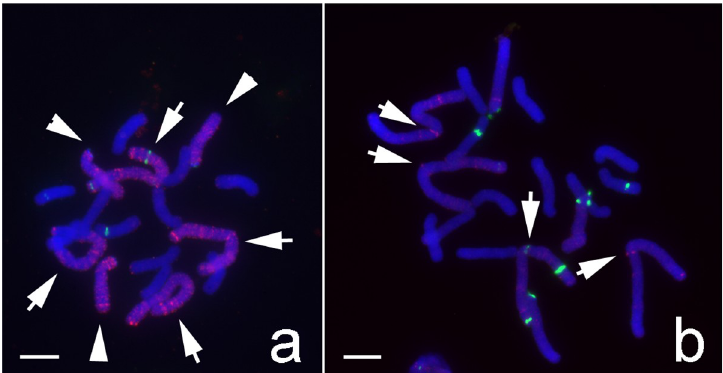
Fig 8. FISH assay showing the abundance and specific distribution of LaCENH3-associated ChIP DNAs on mitotic metaphase chromosomes of hybrid L . aurea × L . radiata (2n = 18, 4M+3T+11A). (Scale bar = 10 μ m). (a) An example of FISH signal pattern for most of the ChIP clones tested shows strong signals (red) dispersed on M-type (arrow) and T-type (arrowhead) chromosomes, but less signals on A-type chromosomes. The green signals indicate the locations of 5S rDNA on individual chromosomes. (b) The FISH signals of LaCenIP-1 (red) show specific distribution pattern on chromosomes. Note the bright FISH signals at the centromeric regions of M-type chromosomes (arrow). The green signals indicate the locations of 5S rDNA on individual chromosomes.